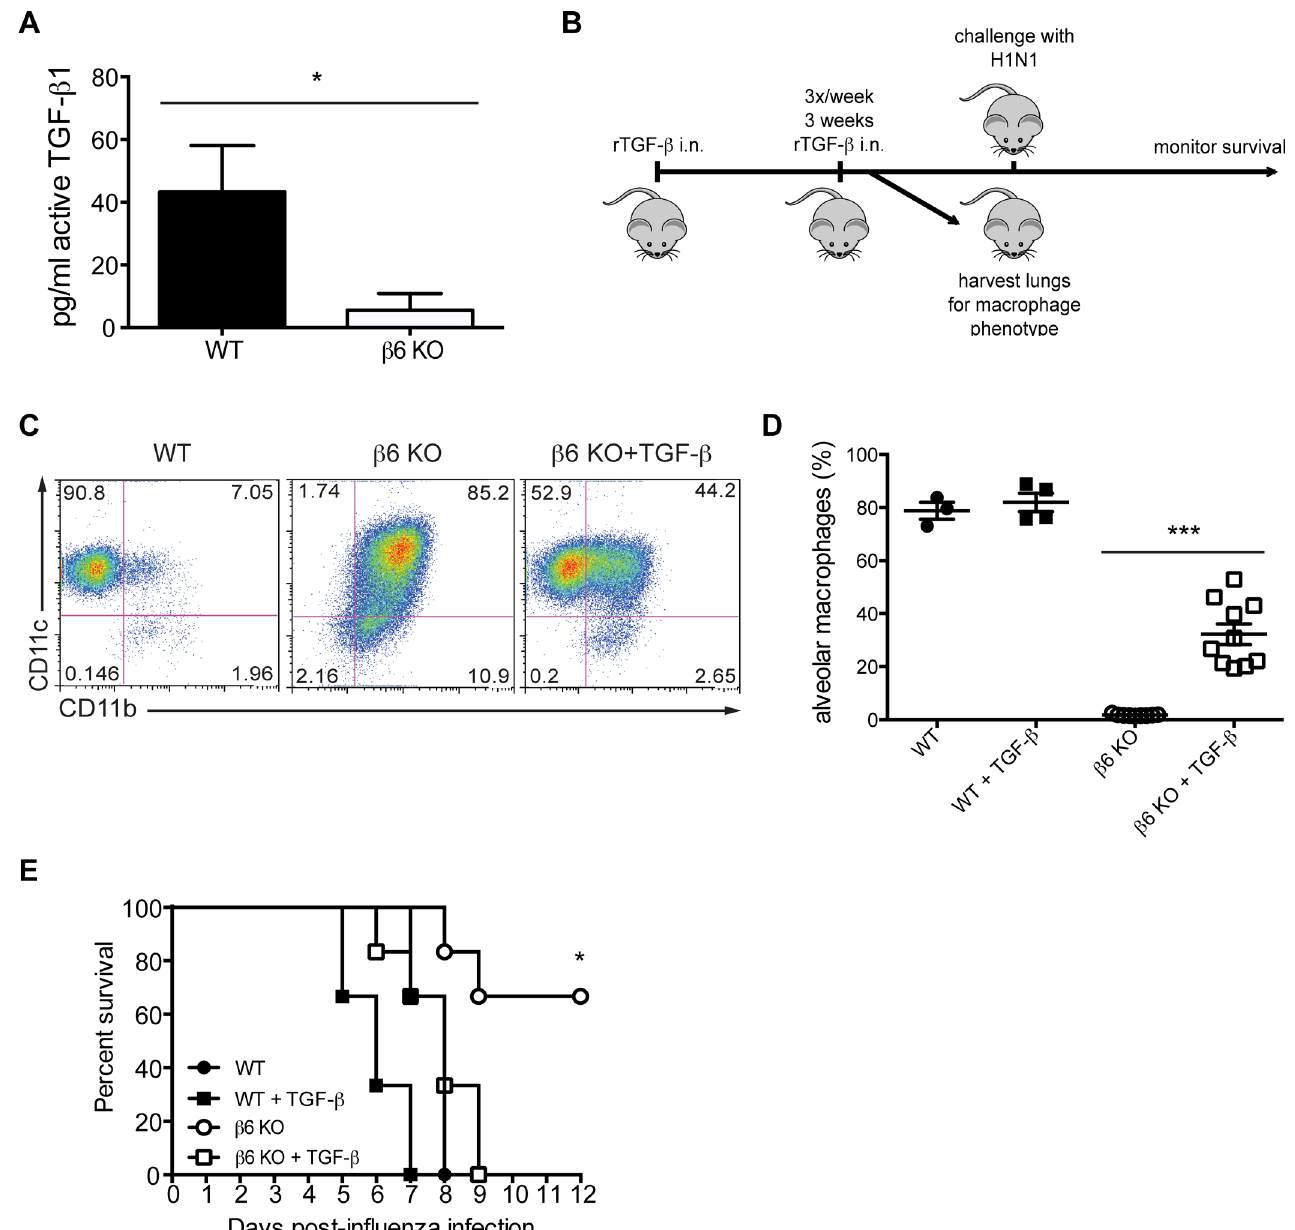
Fig 7. Exogenous TGF- β 1 reverses macrophage phenotype and reverses protection from influenza infection. (A) Active TGF- β 1 was quantified by ELISA in WT (Jackson labs) or β 6 KO mice at homeostasis. (B) Experimental design describing the treatment of mice with exogenous TGF- β 1. (C) Macrophages were isolated from the lungs of uninfected WT or β 6 KO mice treated with or without TGF- β 1 using the gating strategy shown in S2A Fig. Data reflects 2 independent experiments with n = 2 – 6 mice per group. (D) Quantification of CD11c + CD11b - macrophages in mice treated with exogenous TGF- β 1. Data reflects 2 independent experiments with n = 2 – 6 mice per group. **** p < 0.0001 and *** p < 0.001 by one- way ANOVA with Bonferroni post-test. Error bars indicate SEM. (E) Survival of influenza virus infected β 6 KO or WT mice treated with TGF- β 1. Data are pooled from 2 independent experiments with n = 2 – 6 mice per group. β 6 KO mice vs β 6 KO mice + TGF- β 1 p < 0.05 by log-rank (Mantel- Cox)